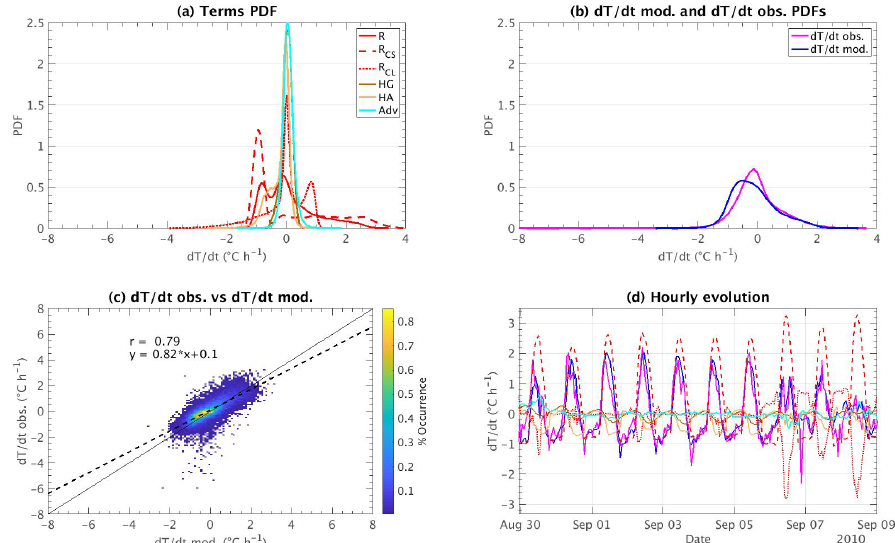
Figure 2. PDFs of (a) radiation (red line), radiative clear sky (red dashed line), radiative cloud (red dotted line), ground heat (dark brown line) and atmospheric heat (light brown line) exchange, and advection (cyan line) terms. (b) ∂T 2m (pink line) and the ∂T 2m (blue line). ∂t obs ∂t mod (c) Scatter plot of ∂T 2m vs. ∂T 2m . The sloping solid line represents the 1:1 line, and the dashed line corresponds to the least-square ∂t obs ∂t mod best fit linear regression line between the two datasets. The correlation coefficient r and the linear equation fitting the best for the two datasets are also indicated. (d) Hourly evolution for September 2010 of the temperature variation for the different terms, the observations, and the model (same colors as in a and b ).